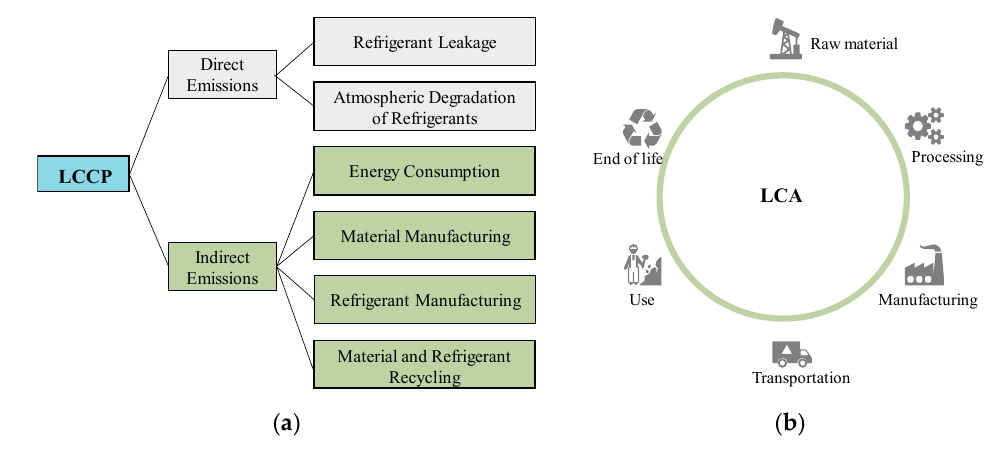
Figure 4. Diagram of LCCP ( a ) and LCA ( b ) method.